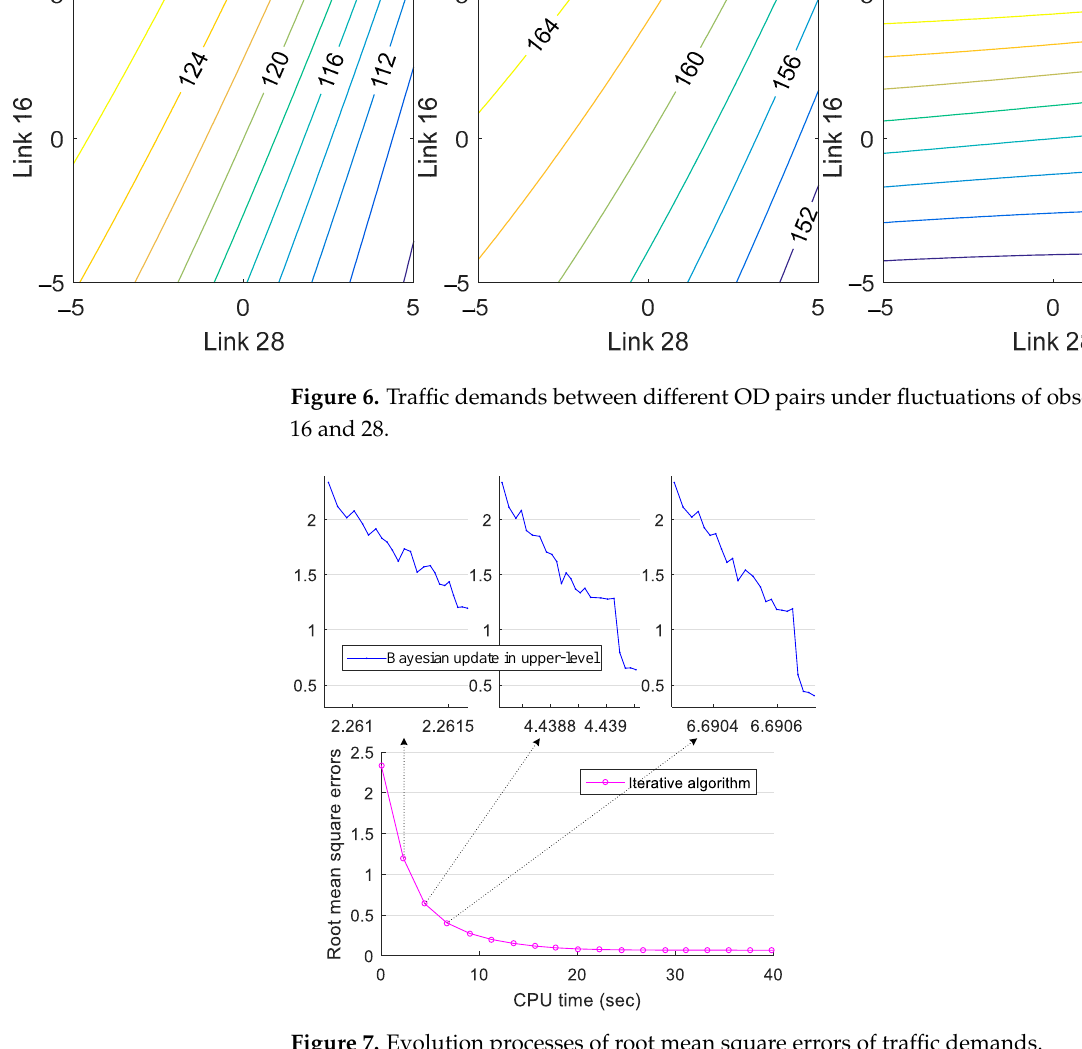
Figure 6. Traffic demands between different OD pairs under fluctuations of observed data on links 16 and 28.